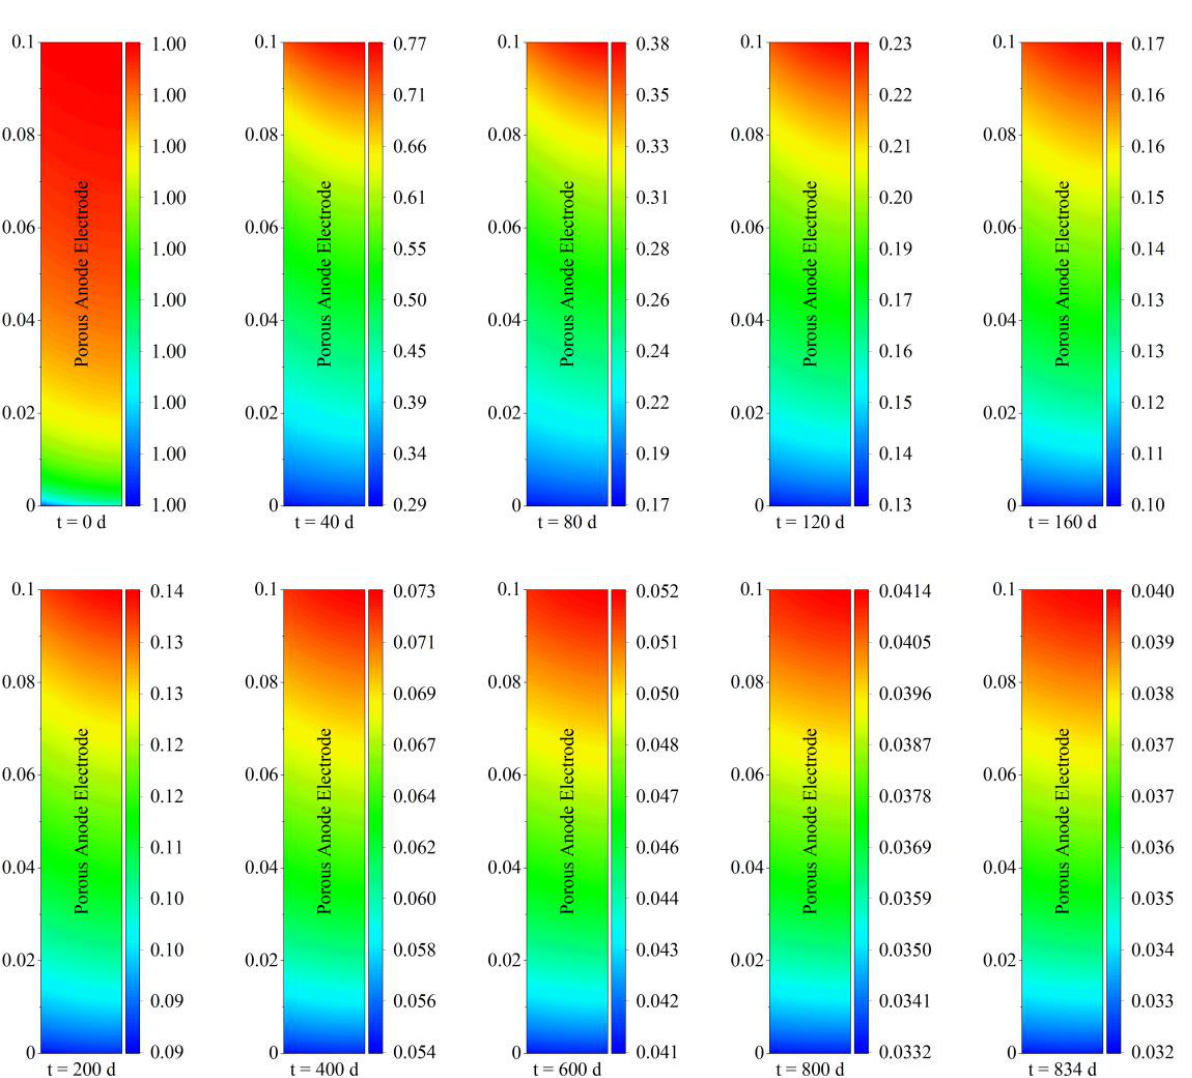
Figure 9. The spatial and temporal evolution of reaction activity within the porous anode electrode of the solid oxide fuel cell during 20,000 h of steady − state operation.